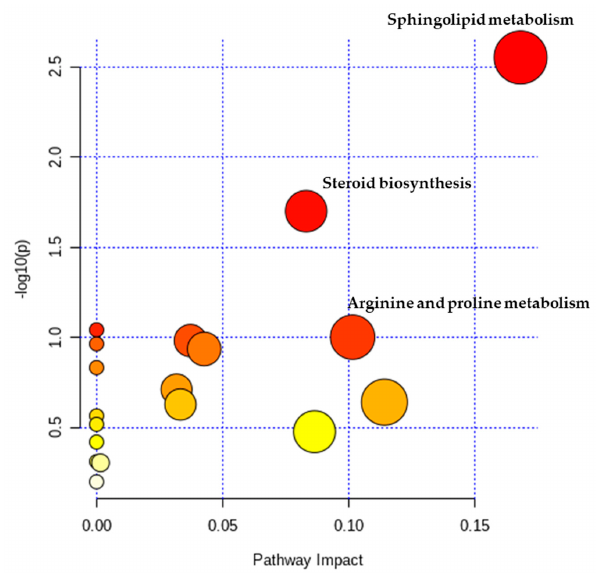
Figure 3. A systemic view of the disordered metabolic pathways associated with surgery. The colors (varying from yellow to red) indicate that the metabolic pathways exhibit different levels of significance, red indicating a more significant pathway than those indicated by yellow circles. All metabolic pathways have been described according to p -values from the pathway enrichment analysis ( y -axis) and impact values based on the pathway topology analysis ( x -axis). Using 200 μ L aliquots of the serum samples, we detected nine polyamines whose concentrations varied from 2.29 to 3764.49 ng/mL (Table 2). We then quantified the metabolic profiles of serum polyamines from all pre-operative ( n = 68) and post-operative ( n = 68) patients with CRC. Table 2. Concentrations of nine polyamines in serum samples from pre- and post-operative patients with colorectal cancer (ng/mL). Compound Pre-Operative Patients ( n = 68)